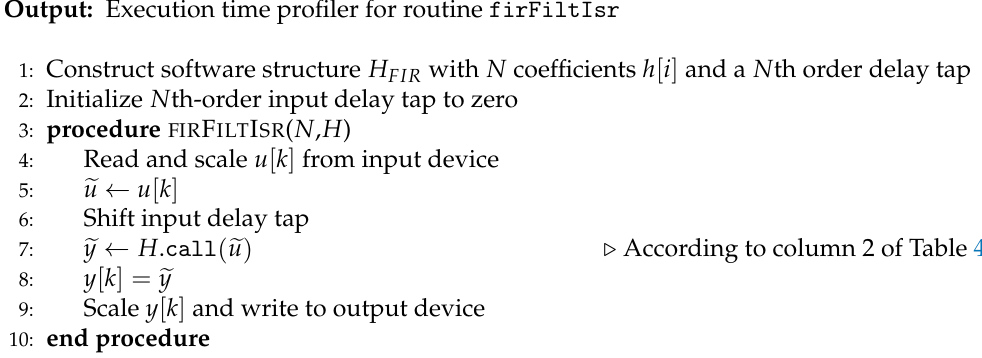
Algorithm 2 Finite-impulse response (FIR) filter interrupt service routine